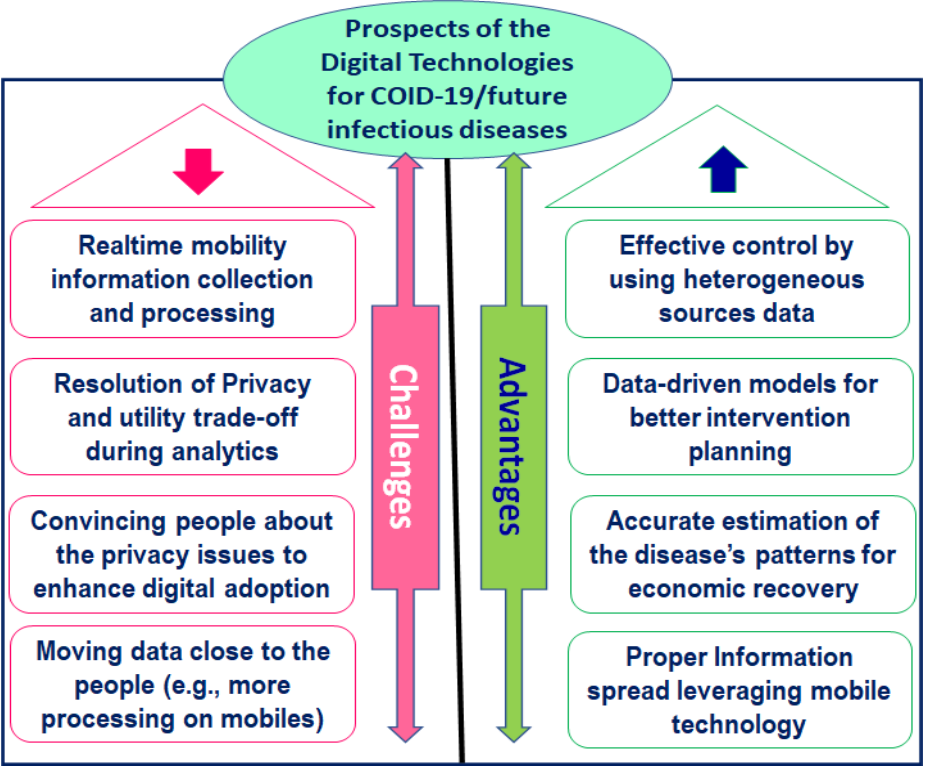
Figure 5. Prospects of the research in privacy area tacking into account the current emerging technologies